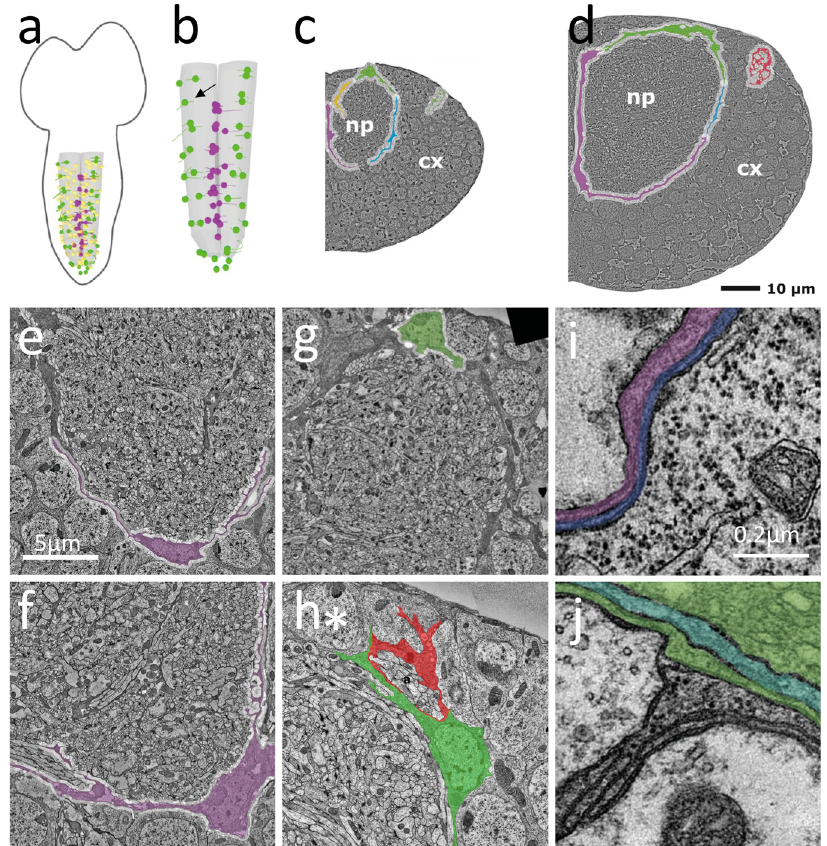
Fig. 2 Larval development of the ensheathing glia. a , b Schematic view on a fi rst instar larval central nervous system. All neuropil-associated glial cells were annotated in a serial section TEM volume. Yellow dots indicate the position of the nuclei of astrocyte-like cells, magenta dots indicate the positions of the ensheathing glial cell nuclei, green dots indicate the positions of the ensheathing/wrapping glial nuclei. The arrow points to a segmental position where only one instead of two ensheathing/wrapping glial cell was identi fi ed. c Representative section through the fourth abdominal hemineuromer of a L1 larva showing the position of three different ensheathing glial cells around the neuropil. d Representative section through the fourth abdominal neuromere of a third instar larval ventral nerve cord. Note that ensheathing glia completely cover the neuropil. It was not determined whether the red marked glial processes belong to the blue or green ensheathing/wrapping glial cell. Scale bar ( c , d ): 10 µ m, ( e – h ): 5 µ m, ( i , j ): 0.2 µ m. e Ensheathing glia in a fi rst and ( f ) in a third instar larva. g Ensheathing/wrapping glial cells in a fi rst and ( h ) in a third instar larva. Note the thin processes that engulf cell bodies of dorsally located neurons (asterisk). i On the ventral face of the neuropil an ensheathing glial cell and a cortex glial cell form a two-layered sheath between cortex and neuropil. j A highly multilayered glial cell layer is found at the dorsal face of the